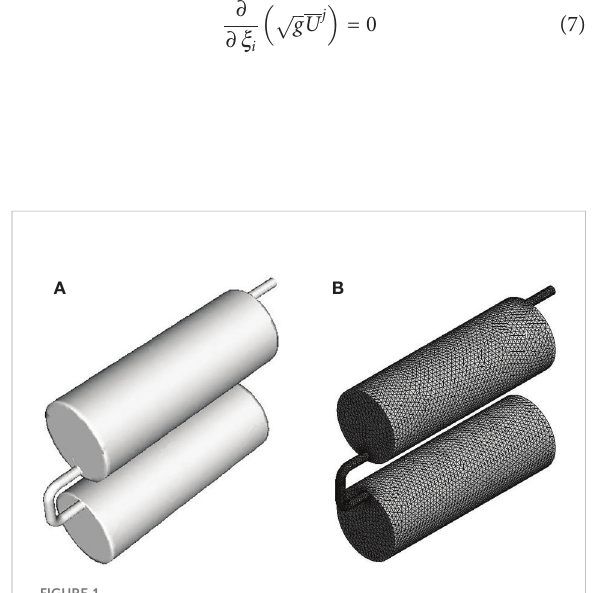
FIGURE 1 numerical calculation model, (A) The internal structure of the sampling channel, (B) CFD calculation mesh